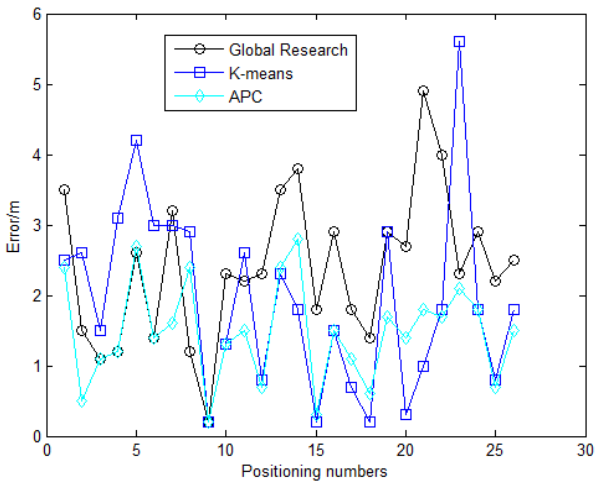
Figure 9. Comparison of static positioning accuracy.